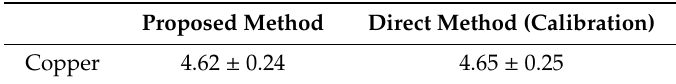
Table 4. Absolute nonlinearity parameter of copper measured by the proposed method and the direct measurement